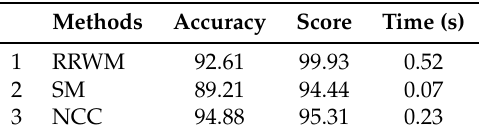
Figure 12. CMU house dataset matching results among ( a ) RRWM, ( b ) SM, and ( c ) NCC algorithms. Table 5. Comparative evaluation on CMU database for reweighted random walk method (RRWM), spectral matching method (SM), and normalized cross-correlation